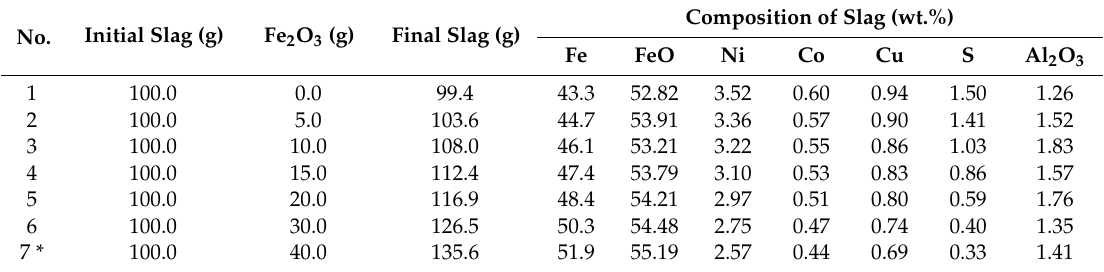
Table 1. Experimental schemes for the desulphurization of initial nickel converter slag with Fe 2 O 3 . No. Initial Slag (g) Fe 2 O 3 (g)